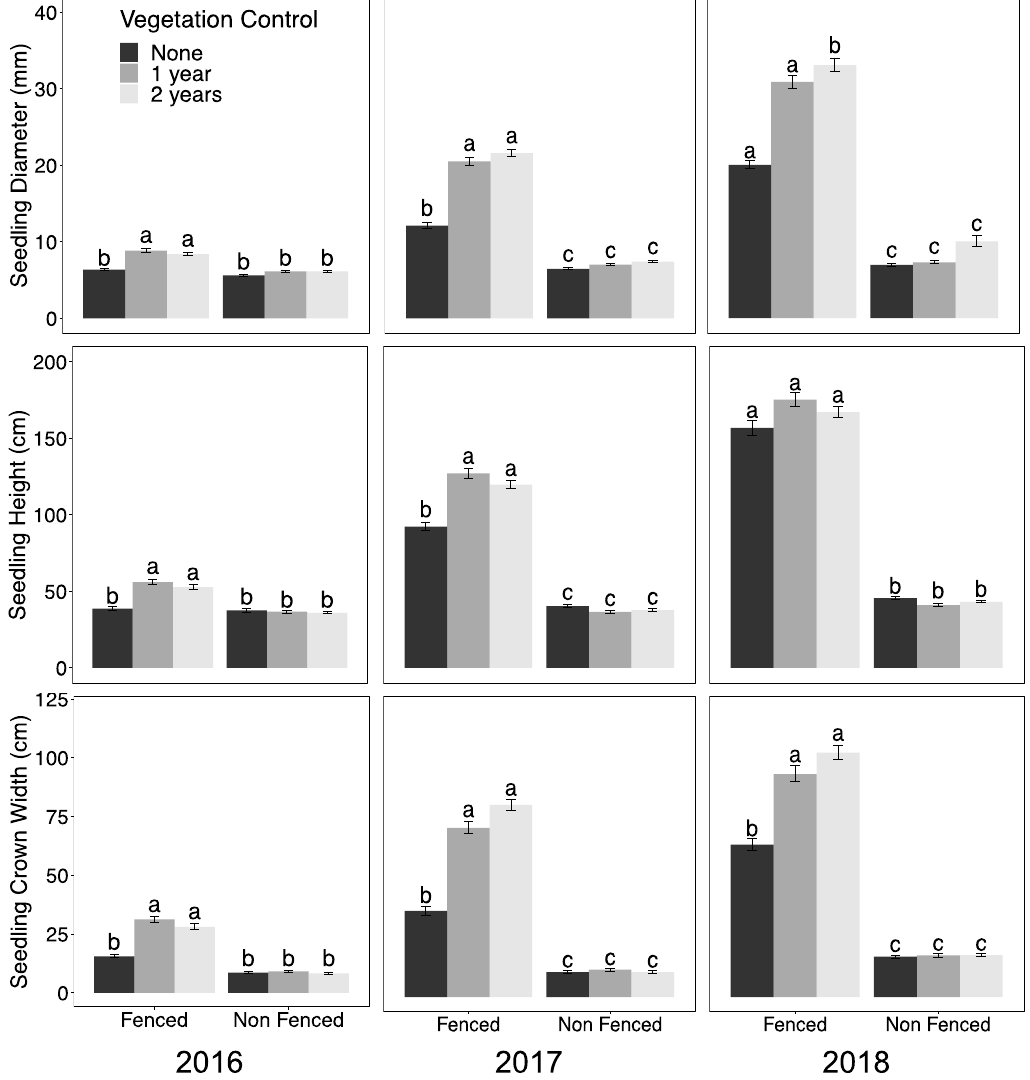
Figure 1. Mean ± SE diameter, height, and crown width growth of Q. virginiana seedlings after each of the three growing seasons. Seedlings were planted in fenced or non-fenced plots and competing vegetation was not removed or removed for one year or two years. In 2016, both vegetation control treatments (one year and two years) were the same. In 2017, vegetation control was done solely for the two-year treatment. Different letters indicate significant differences among the interaction of fencing and vegetation control treatments ( α = 0.05).